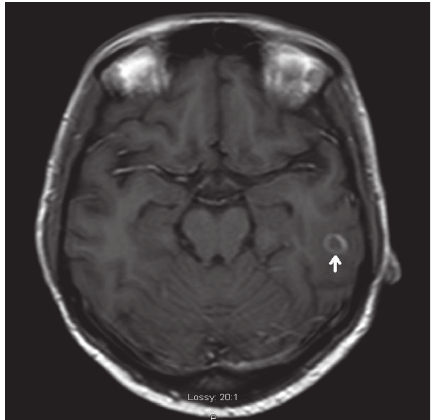
Figure 5: MRI brain showed a peripheral lesion with ring en- hancement measuring 1cm (arrow) in the posterior left temporal lobe with surrounding vasogenic edema without significant mass effect in the ipsilateral basal